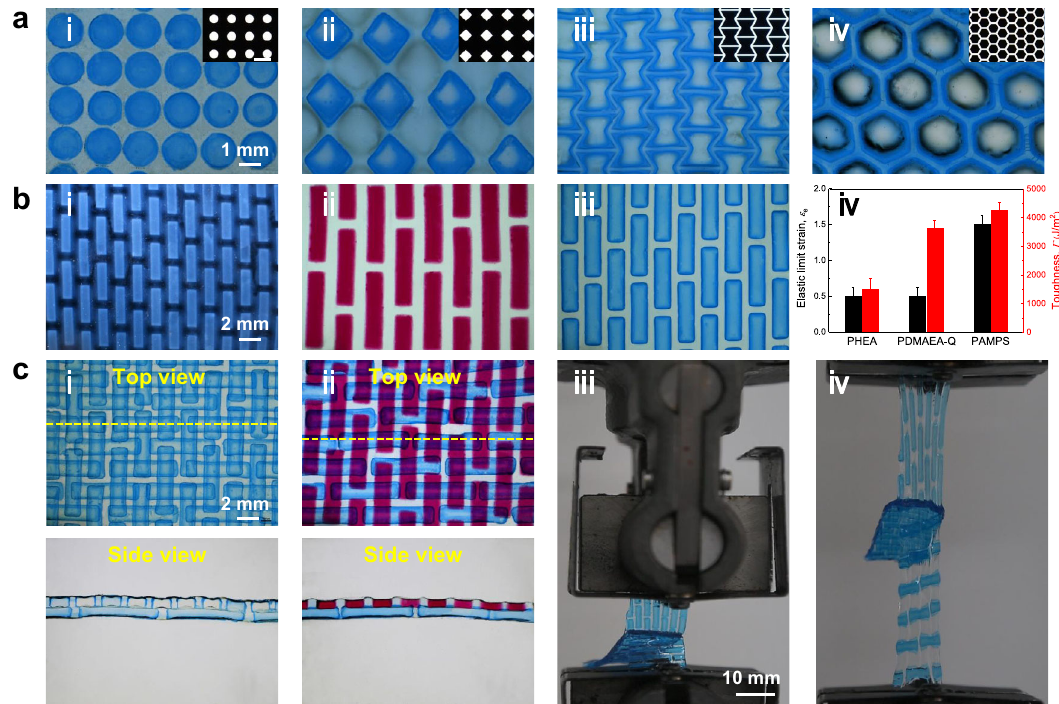
Fig. 4 Extensibility of TPNs in geometric patterns, material combinations, and multilayers. a Discrete (i, ii) and continuous (iii, iv) architectures in TPNs. The insets show the mask micrographs. b Micrographs of three representative TPNs in which the hard phases are made of neutral poly(hydroxyethyl acrylate) (PHEA) (i), cationic poly( N,N -dimethylamino ethylacrylate methyl chloride quarternary) (PDMAEA-Q) (ii), and anionic PAMPS (iii), along with their elastic limit strain and toughness (iv). At least three samples were tested for the calculation of average value and standard deviation. c Micrographs and peel test of bilayer TPNs with orthogonal staggered pattern. The bilayer is assembled by two identical PAMPS-based gels (i) or one PAMPS-based gel and the other PDMAEA-Q-based gel (ii). The yellow dashed lines represent the position of the cross-section for the side view. A crack is introduced at the interface of the bilayer (iii). When the bilayer is peeled, the two layers stretch and the crack does not advance